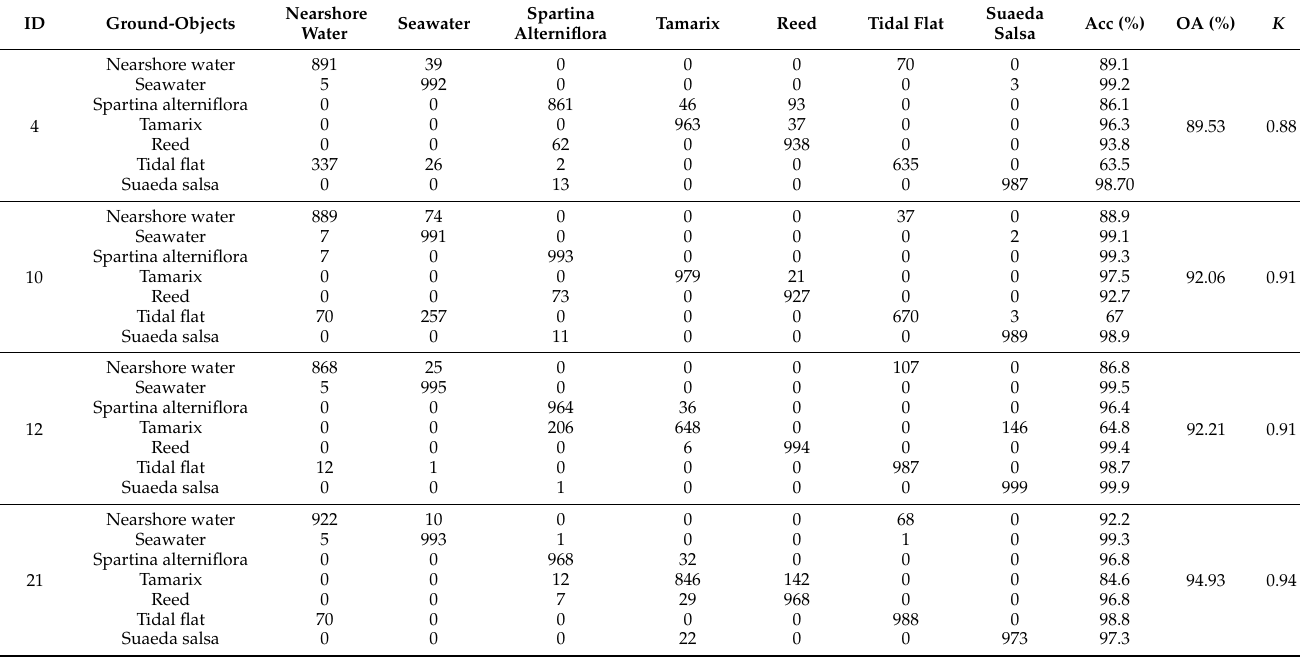
Table 5. Confusion matrixes of the four schemes on